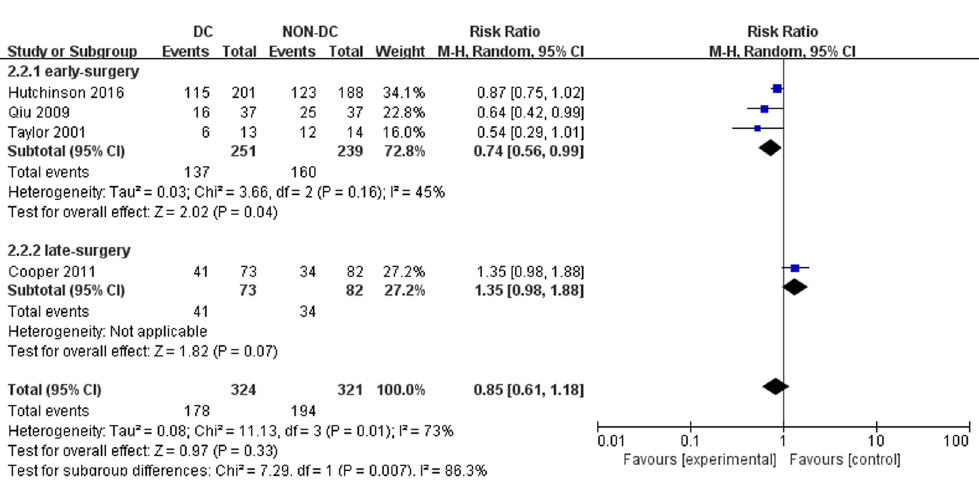
Figure 3. Forest plots for the effect of DC versus NON-DC on GOS scores at 6 months. DC, Decompressive Craniectomy; GOS, Glasgow Outcome